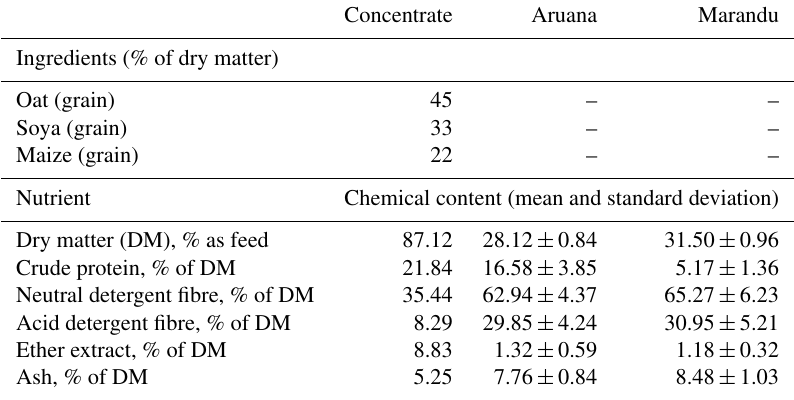
Table 1. Proportion of ingredients in concentrate (milled mixture of grains) and chemical content of concentrate and forages. Concentrate Aruana Marandu Ingredients (% of dry matter)